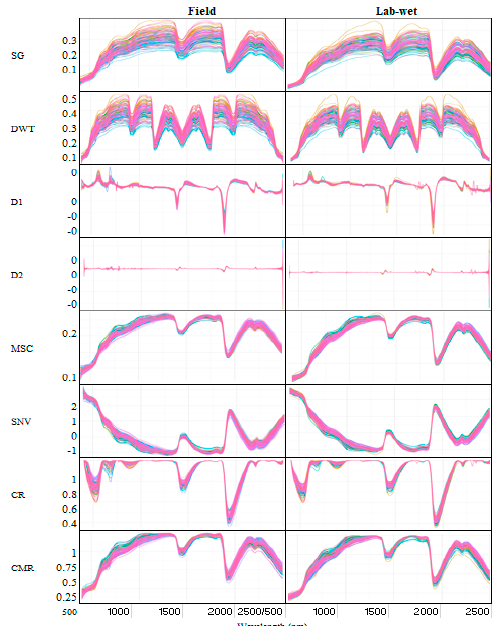
Figure 2. Spectra transforms for both field and lab-wet dataset based on eight di ff erent pretreatment methods